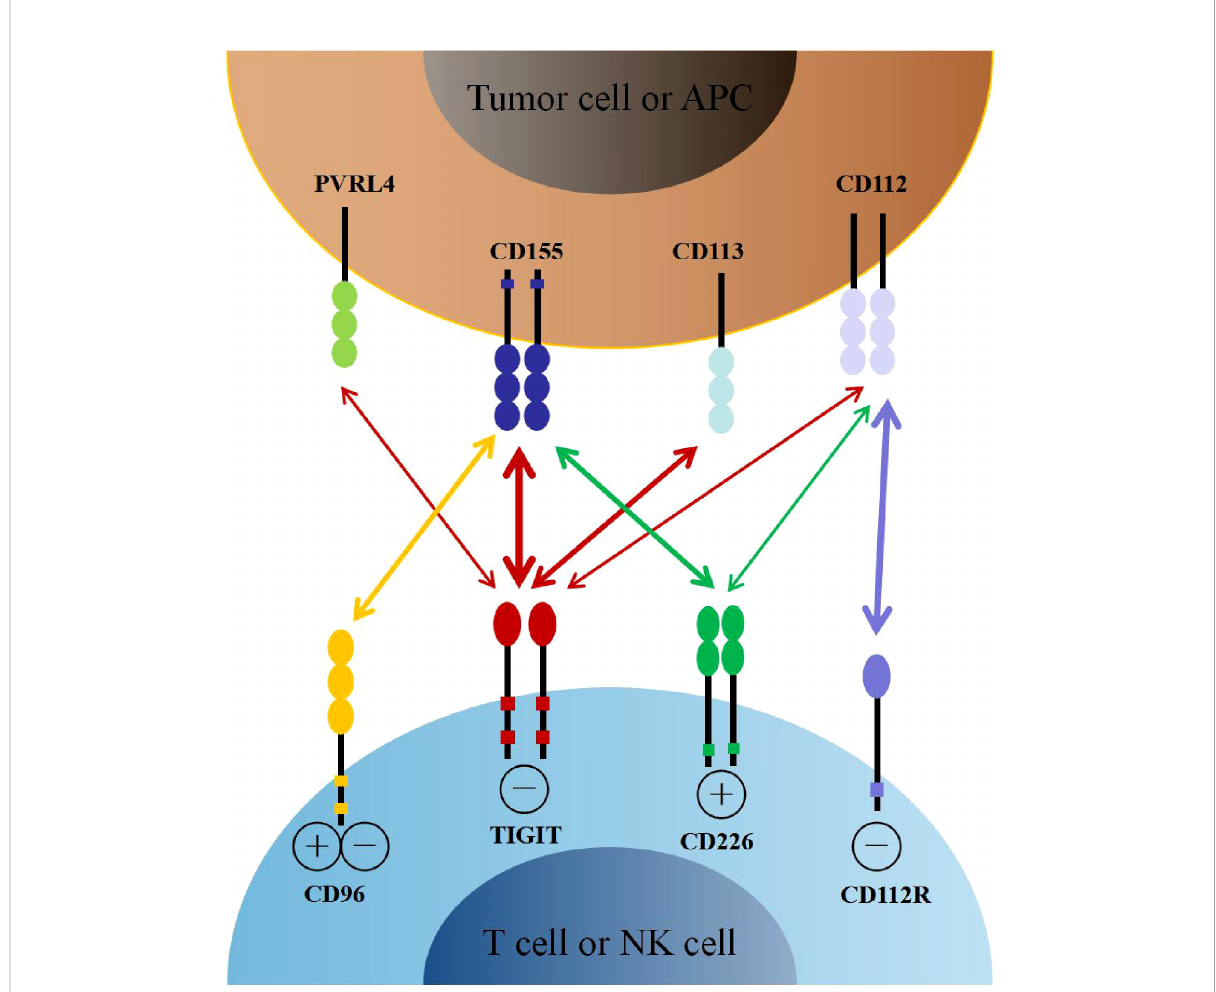
FIGURE 1 The interaction of TIGIT family receptors and ligands. TIGIT, CD226, CD96 and CD112R are expressed on T cells and NK cells. The ligands CD155, CD113, CD112 and PVRL4 are expressed on tumor cells or APCs. TIGIT delivers inhibitory signals by binding to CD155, CD113, CD112 and PVRL4, with highest af fi nity for CD155. CD226 and CD96 compete with TIGIT for binding to CD155, but with lower af fi nity than TIGIT. CD226 delivers activating signals. However, whether CD96 triggers inhibitory or activating signals remains to be determined. CD112R and CD226 also competitively binding to CD112, with higher af fi nity with CD112R. APCs, antigen presenting